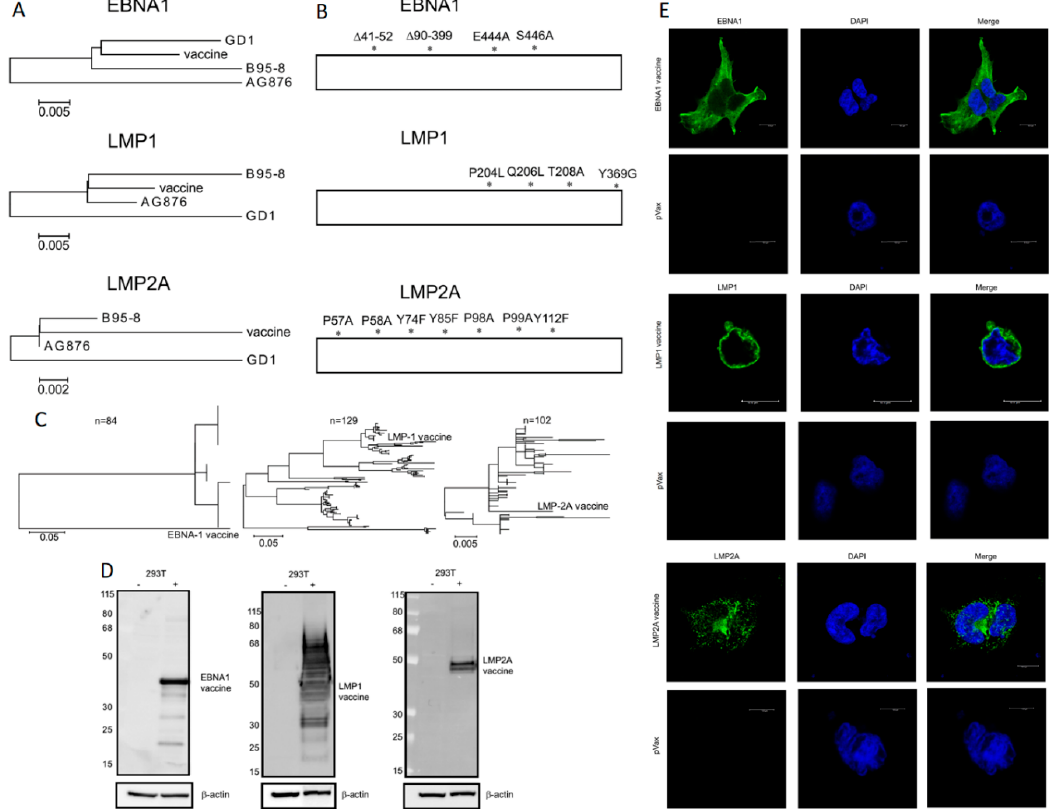
Figure 1. Design and expression of EBNA1vax, LMP1vax, and LMP2Avax vaccine antigens. ( A ) Diagram showing the similarity of the consensus sequence of the EBNA1, LMP1, and LMP2A vaccines, generated from the sequences of EBV strains B95-8, AG876, and GD1. The vaccine antigen designs use a SynCon sequence embedded in a pVAX plasmid. ( B ) Modifications were made to the consensus vaccine antigens to avoid potentially oncogenic properties and repetitive sequences. ( C ) Phylogenic trees showing relationship of vaccines to known EBV latent protein sequences. ( D ) Western blots showing the expression of vaccine antigens in untransfected cells (left columns) and cells transfected with the DNA vaccine (right columns). Beta-actin was used as a loading control. ( E ) Immunofluorescence images showing expression of the vaccine antigens in 293T cells, with cytoplasmic EBNA1vax, LMP1vax on the outer membrane, and LMP2Avax showing a vesicular localization. Antigens are labeled in green, and DAPI (4 ′ ,6-diamidino-2-phenylindole) shows the nucleus in blue. Scale bars are 10 μ m.